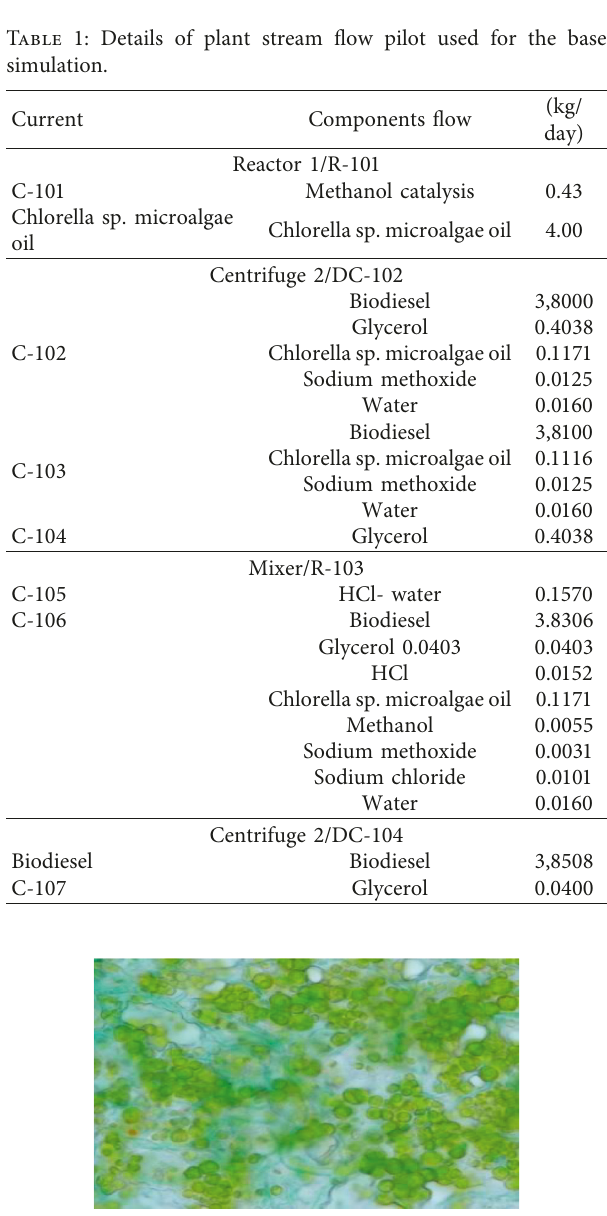
Figure 2: The photo view of Chlorella sp. micro